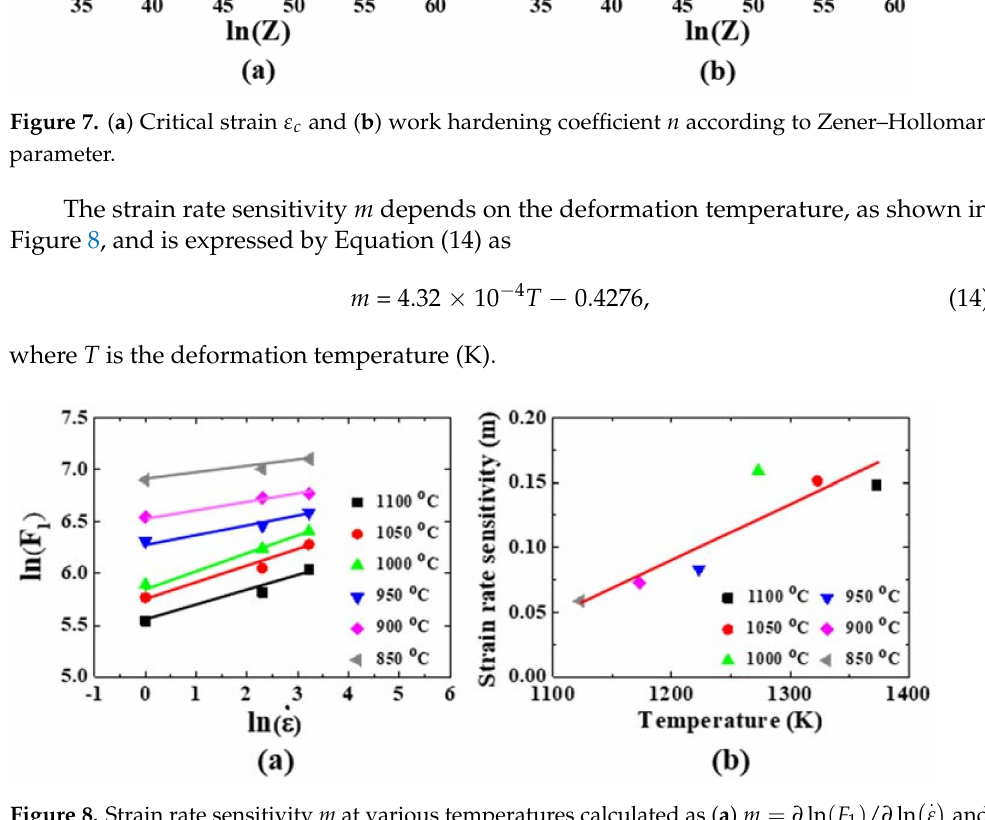
Figure 8. Strain rate sensitivity m at various temperatures calculated as ( a ) m = ∂ ln ( F 1 ) / ∂ ln ( b ) the regression of the strain rate sensitivity m as a function of